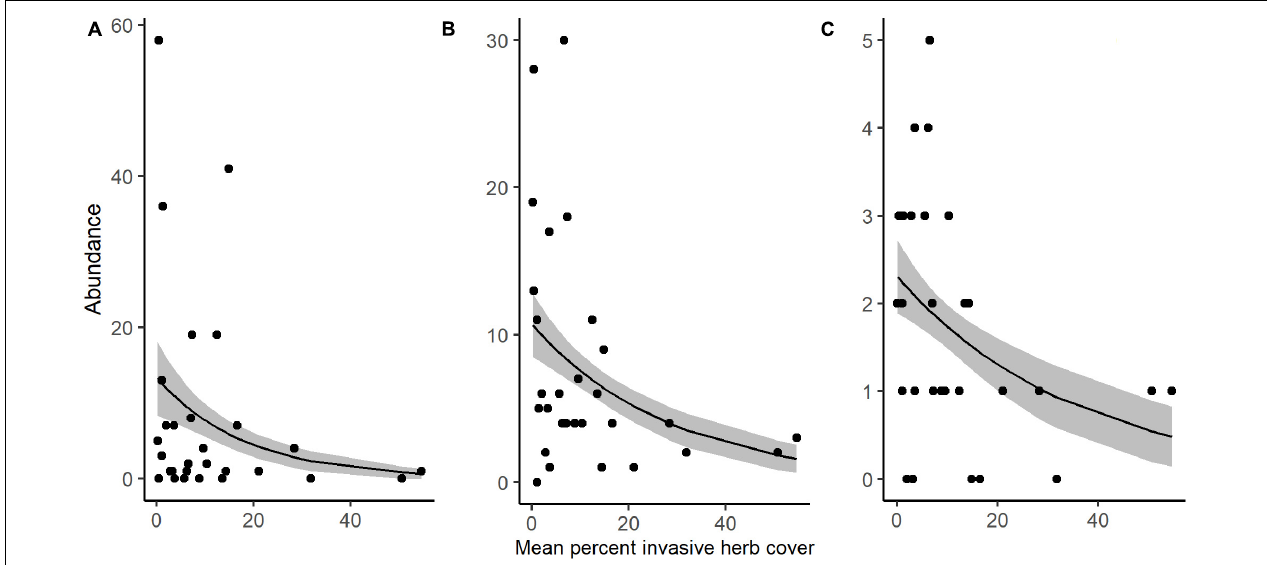
FIGURE 5 | Response of (A) Collembola, (B) Hymenoptera: Formicidae, and (C) Lepidoptera abundance to increased percent ground cover of invasive herbaceous plants in sampled plots. Black points represent raw abundance data, lines depict fitted models, and gray shading represents ± 1